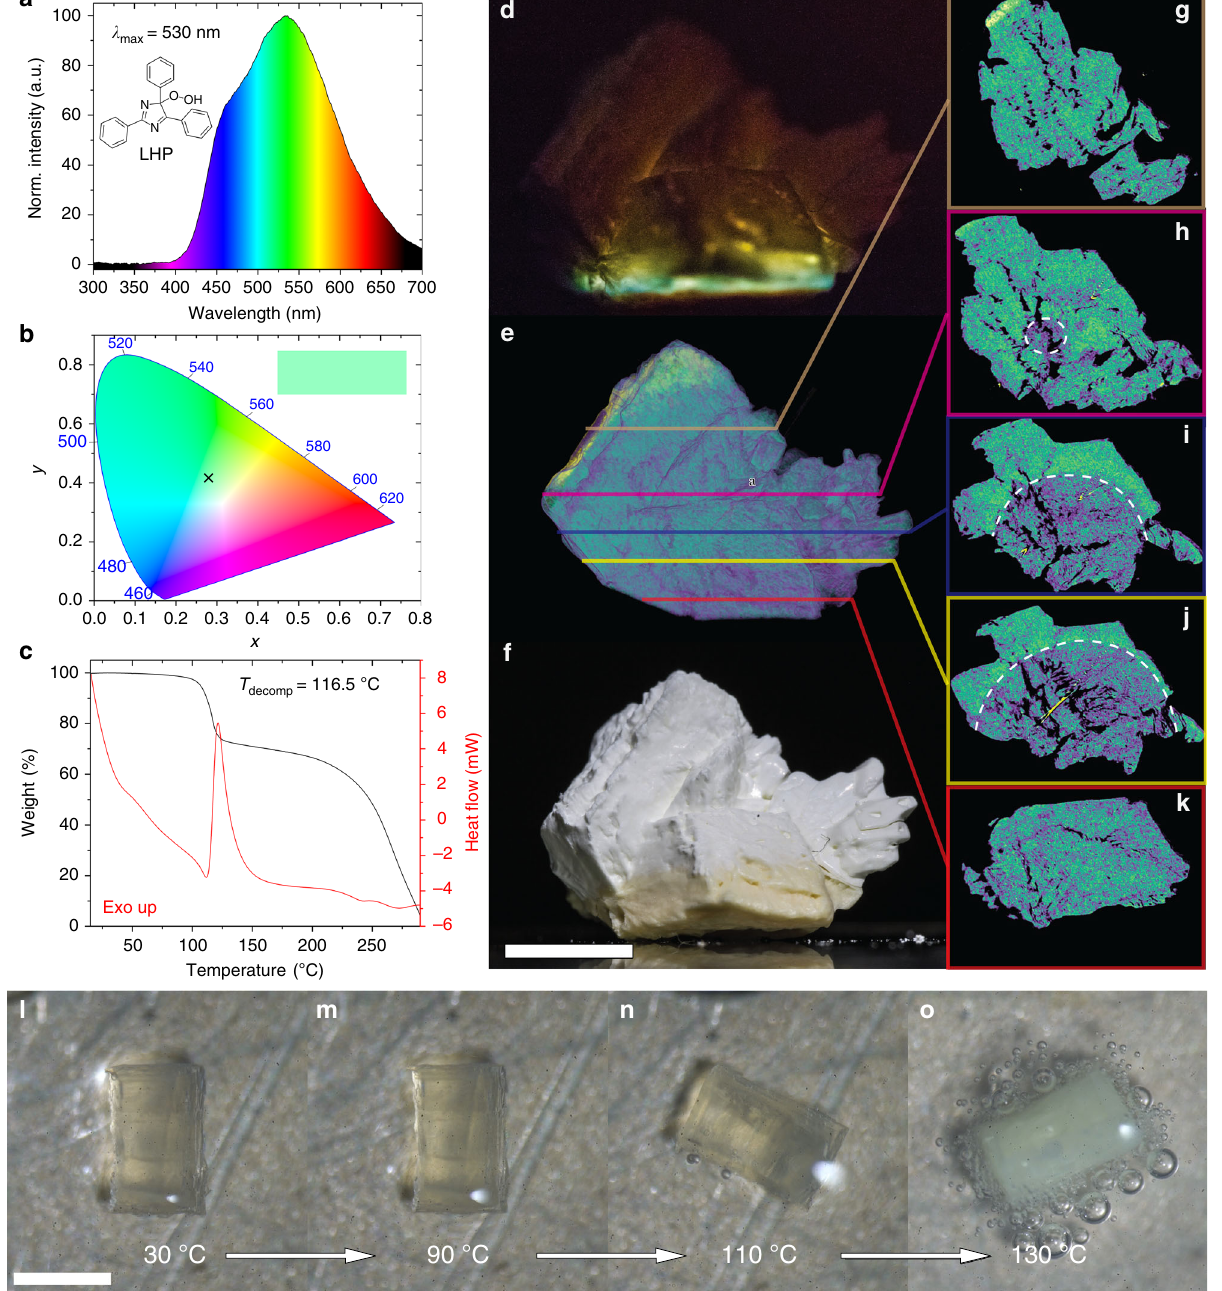
Fig. 1 Thermochemiluminescence and decomposition of LHP. a Molecular formula and solid-state thermochemiluminescence spectrum of LHP ( λ max is the wavelength of maximum emission). b Color of the light emission plotted on a CIE (International Commission on Illumination) 1931 color space diagram showing the position of the thermochemiluminescence of LHP with coordinates x = 0.2854 and y = 0.4009. c Thermogravimetry of solid LHP showing its decomposition at 116.5 °C ( T decomp stands for decomposition temperature). d Thermochemiluminescence of a crystal agglomerate of LHP heated from the bottom (recording of the light emission is available as Supplementary Movie 4). The difference in color of the emitted light at different locations is caused by direct emission and reabsorption/ fi ltering of the emitted light through the interior of the crystal. e Computed tomography (CT) scan of the partially reacted crystal. f Bright- fi eld image of the same crystal after the reaction. The reacted part of the crystal is seen as discolored section. g ‒ k 2D slices taken at varying depth through the 3D CT scan showing different densities in the reacted and non-reacted domains of the crystal (the 3D scan is available as Supplementary Movie 5). l ‒ o A crystal of LHP heated in a drop of oil to 110 °C starts to decompose by release of oxygen, as seen by the evolution of bubbles. The length of the scale bar in f (also applies to d and e ) is 1 cm. The length of the scale bar in l (also applies to m ‒ o ) is ~1